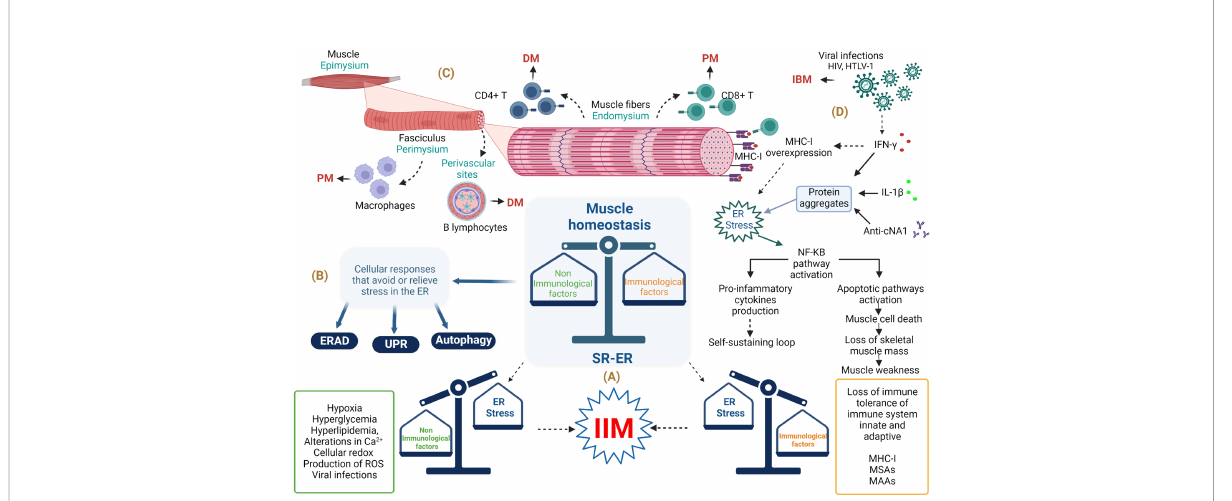
FIGURE 1 Involvement of endoplasmic reticulum stress in the musculoskeletal system in idiopathic in fl ammatory myopathies. (A) Immunopathological and non-immunopathological factors with possible repercussions on homeostasis of the musculoskeletal system. (B) ER stress relief mechanisms. (C) Histological importance in the diagnosis of IIM. (D) Involvement of immune and non-immune responses in IBM . Abbreviations: anti-cN1A, anti-cytosolic 5 ’ -nucleotidase 1A antibodies; DM, dermatomyositis; ER, endoplasmic reticulum; ERAD, endoplasmic reticulum – associated protein degradation; HIV, human immunode fi ciency virus; HTLV-1, human T lymphotropic virus; IBM, inclusion body myositis; IFN- g , interferon gamma; IIM, idiopathic in fl ammatory myopathy; IL-1 b , interleukin-1 beta; MHC-1, major histocompatibility complex class I; MSAs, myositis- speci fi c antibodies; MAAs, myositis-associated auto-antibodies; NF-KB, nuclear factor k B; PM, polymyositis; ROS, reactive oxygen species; SR- ER, sarcoplasmic reticulum – endoplasmic reticulum; UPR, unfolded protein response. The fi gure was created with BioRender.com (agreement no.